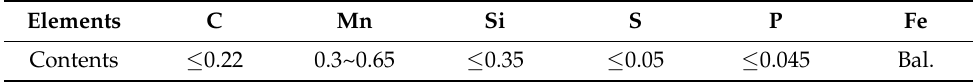
Table 1. Chemical composition of Q235 steel (wt. %).